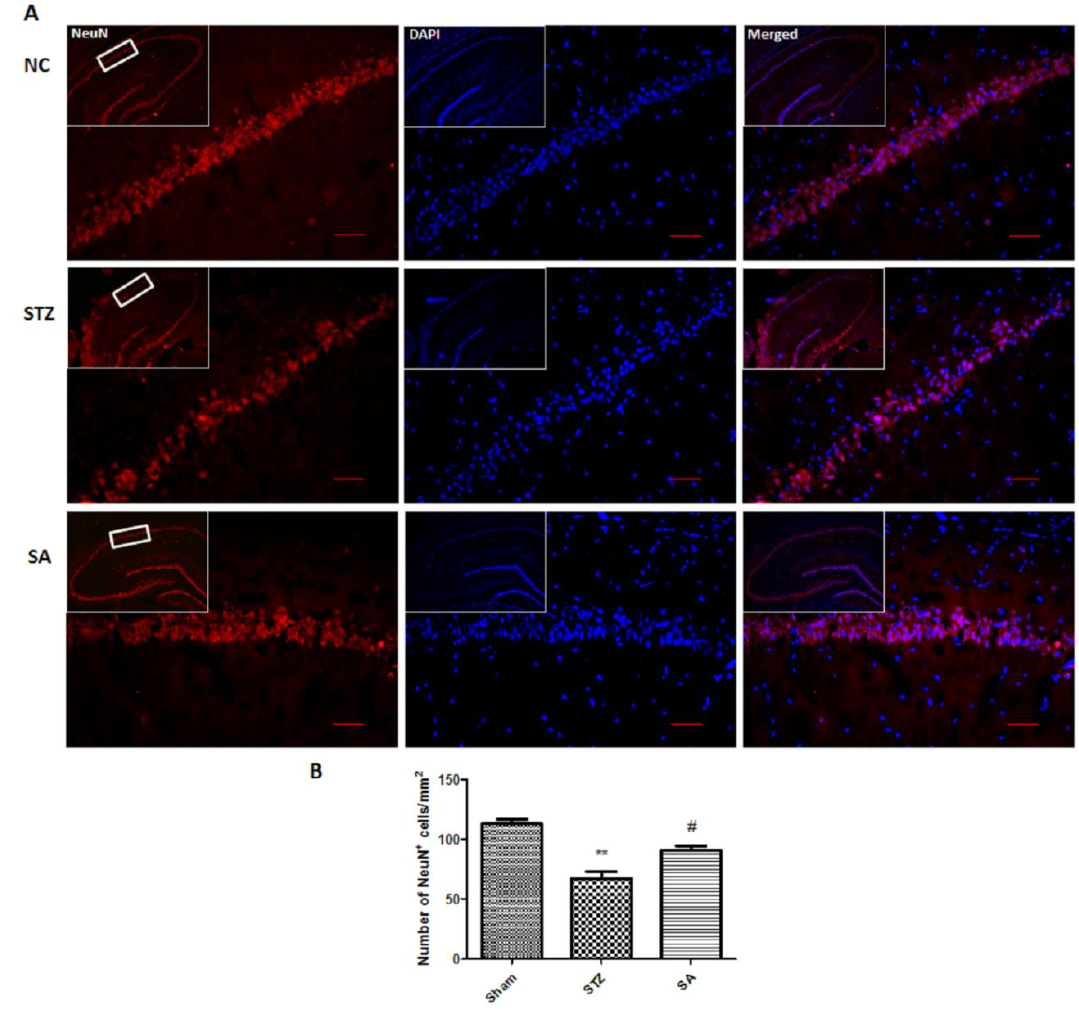
Figure 10. Effect of SA on STZ-induced neuronal loss. ( A ). Representative photomicrographs showing the effect of SA on neuronal loss in the CA1 region of the hippocampus (scale bar = 100 µm). ( B ). The bar diagram revealed a significant increase in the number of surviving neurons in the SA group as compared to the STZ group. Data are presented as mean ± SEM, ( n = 3). * as compared to the sham group, # as compared to the STZ group. ** p < 0.01, # p < 0.05. STZ—Streptozotocin, SA—Sinapic acid.